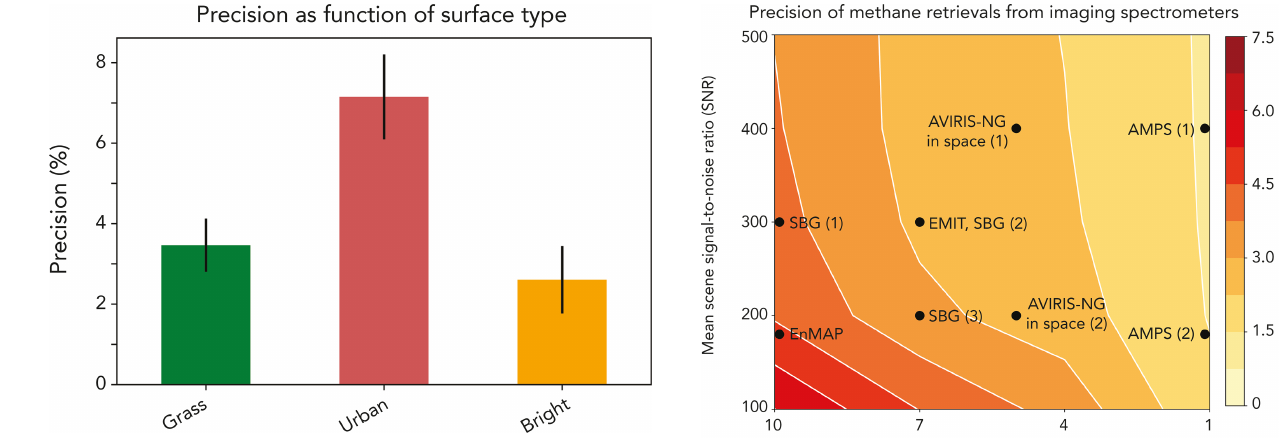
Figure 5. Precision of methane retrievals for spaceborne imag- ing spectrometers observing in the SWIR (2210–2400nm), as a function of instrument signal-to-noise (SNR) and full-width-at-half- maximum (FWHM) spectral resolution. The SNR values are for a reference 30 ◦ solar zenith angle and 0.3 surface reflectivity with clear sky, same as in Table 1. Actual SNR for individual pixels may vary, depending in particular on surface reflectivity. Precision is expressed as the relative residual standard deviation (RRSD) of the difference between retrieved and true methane columns over three synthetic scenes of Fig. 2 (grass, urban, bright) including point sources of 100–900kgh − 1 and for 15 different WRF-LES plume realizations. Black dots show different instrument specifi- cations from Table 1. Specifications for the SBG and AMPS in- struments are still at the design stage, and values shown here are for the ranges under consideration. Results given for AVIRIS-NG are for a satellite instrument with 30m × 30m pixel resolution but other specifications (spectral resolution, SNR) same as the airborne